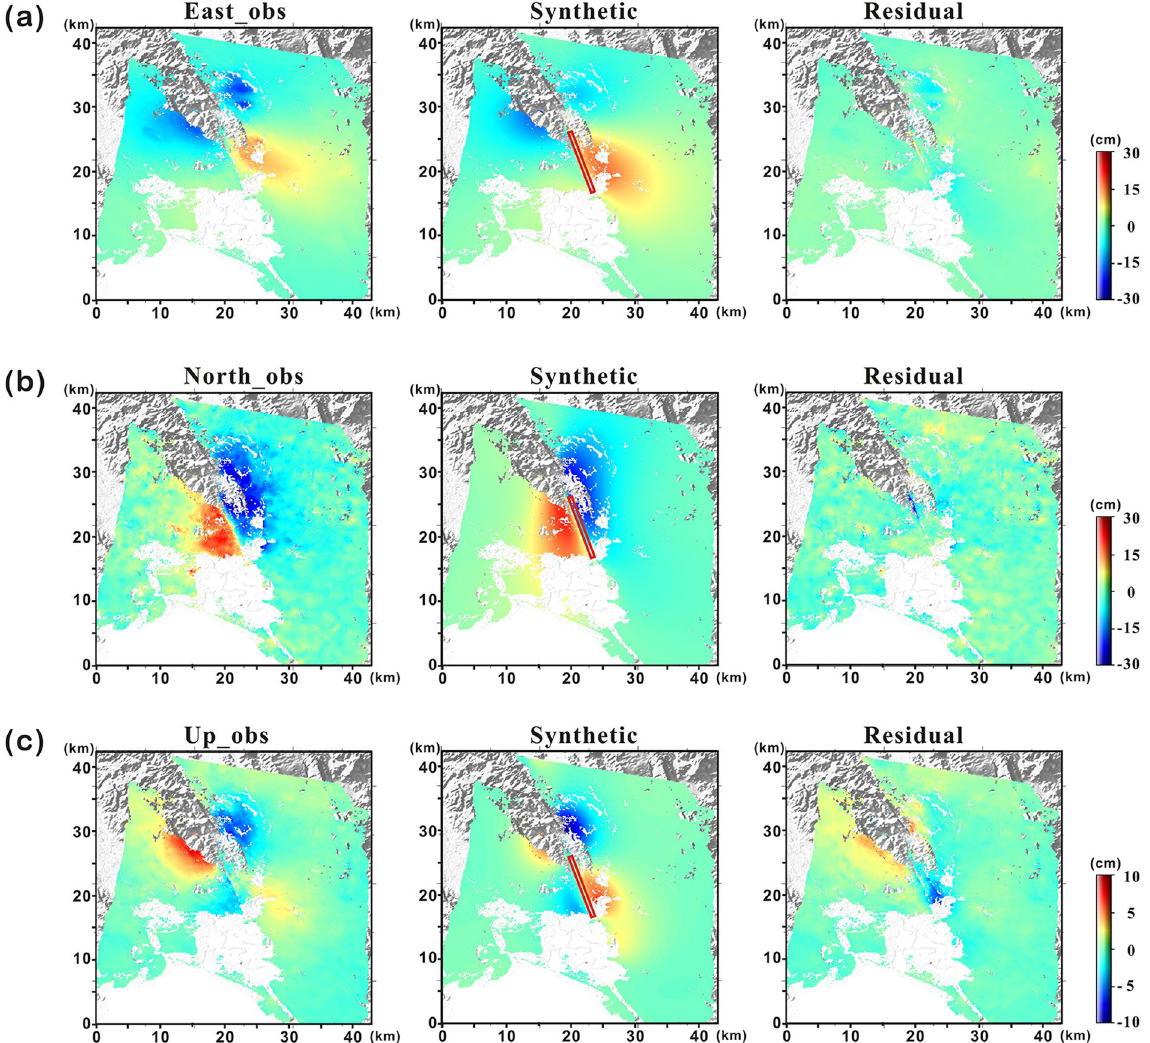
Figure 6. Inversion results of the dislocation model for the South Napa earthquake using 3D displacement maps: observed (left), synthetic (centre), and residual (right) displacements of the ( a ) east, ( b ) north, and ( c ) up components of surface deformation. The displacement maps were produced by using the GMT software 5.3.2 version (http://gmt.soest.hawaii.edu/projects/gmt/wiki/Download).